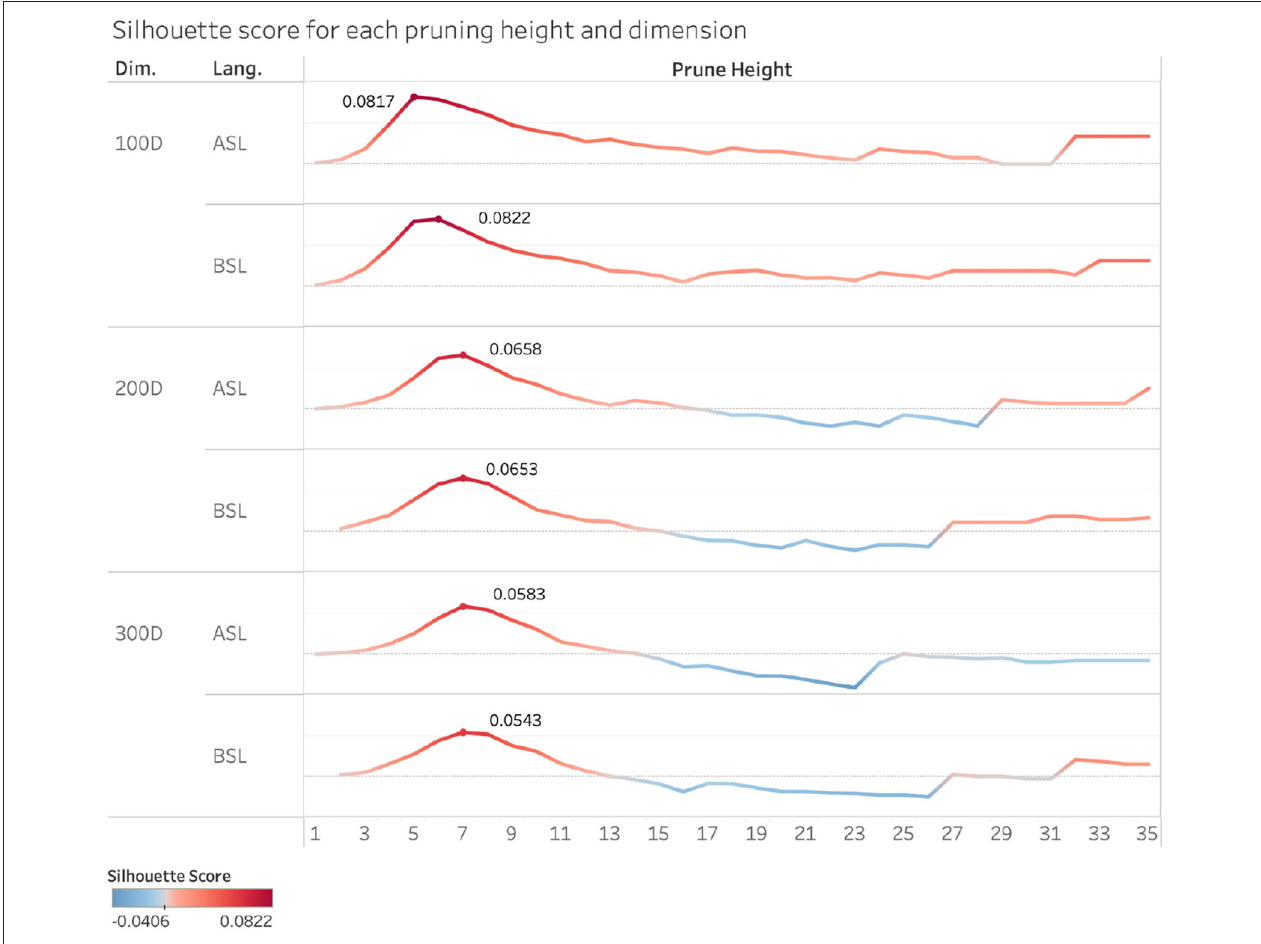
FIGURE 6 | Silhouette scores in ASL and BSL across semantic spaces (100-, 200-, and 300-dimensional semantic space) and pruning heights. (1–35%). A score of 0 indicates there are multiple data points that overlap in clusters. A scores of -1 indicates that data points are assigned to incorrect clusters.